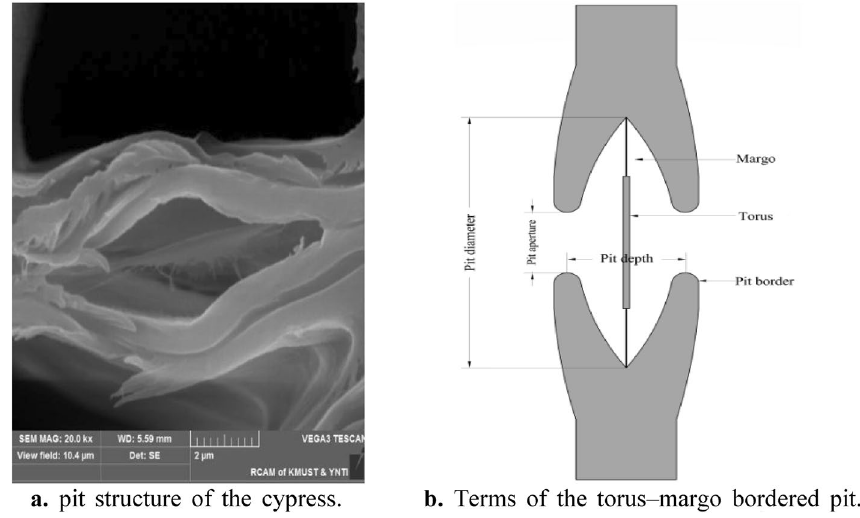
Figure 1. ( a ) pit structure of the cypress. ( b ) Terms of the torus–margo bordered